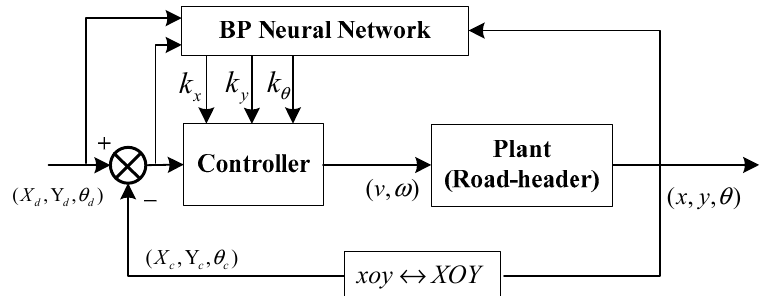
Figure 5. Path tracking results using different sets of values. ( a ) The differences between the planned positions along path #1 and the real positions during tracking; ( b ) The differences between the planned positions along path #2 and the real positions during tracking.